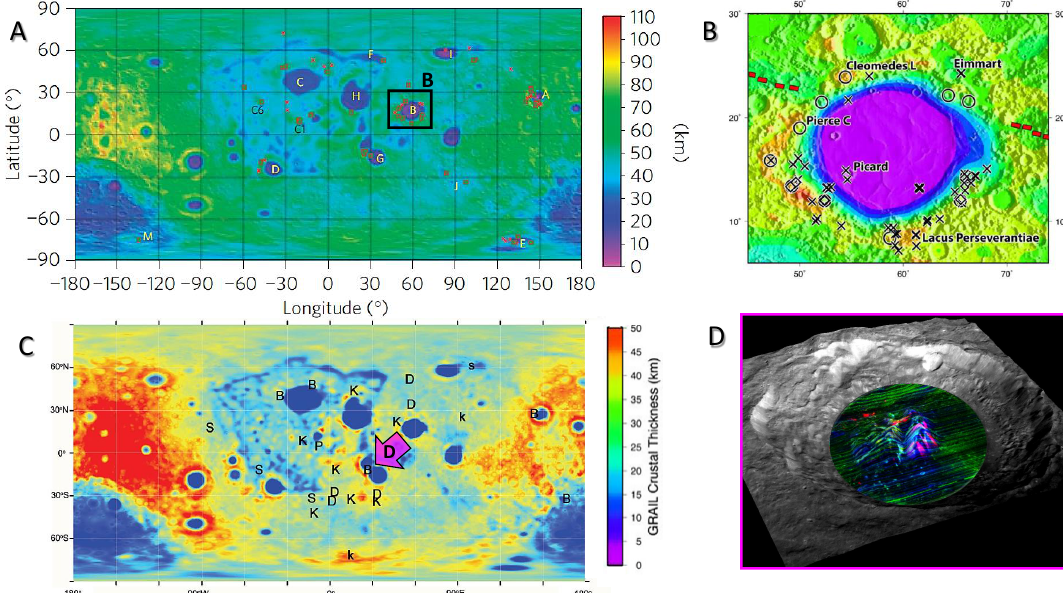
Figure 10. Global distribution of minerals with high resolution geologic context. ( A ) Preferential distribution of olivine exposures around impact basins. Possible mantle origin has been suggested based on detailed analyses (Source: [210]) . ( B ) Olivine exposures at Crisium basin (shown by various symbols). Anomalously high concentration of olivine-bearing exposures is documented. Diverse origins have been proposed. Base map is crustal thickness overlain on topography. Red dotted line corresponds to GRAIL defined linear gravity anomaly. (Source: [211]) . ( C ) Distribution of Mg-Spinel Anorthosite, the new rock type on the Moon. Preferential occurrence around basins and locations of low crustal thickness has been suggested. The pink arrow marks the location of Theophilus crater, shown in D (Source: [204]) . The different letters refer to geologic setting (B—Basin, D—Dispersed, K—Knobs, P—Pyroclastic, S—Special). ( D ) Mg-Spinel exposures (red and pink) concentrated in the central peaks of Theophilus crater (Source: Modified after [203]) . Red, Green and blue colors represent band strength at 2 µ m, 1 µ m and 1.25 µ m,